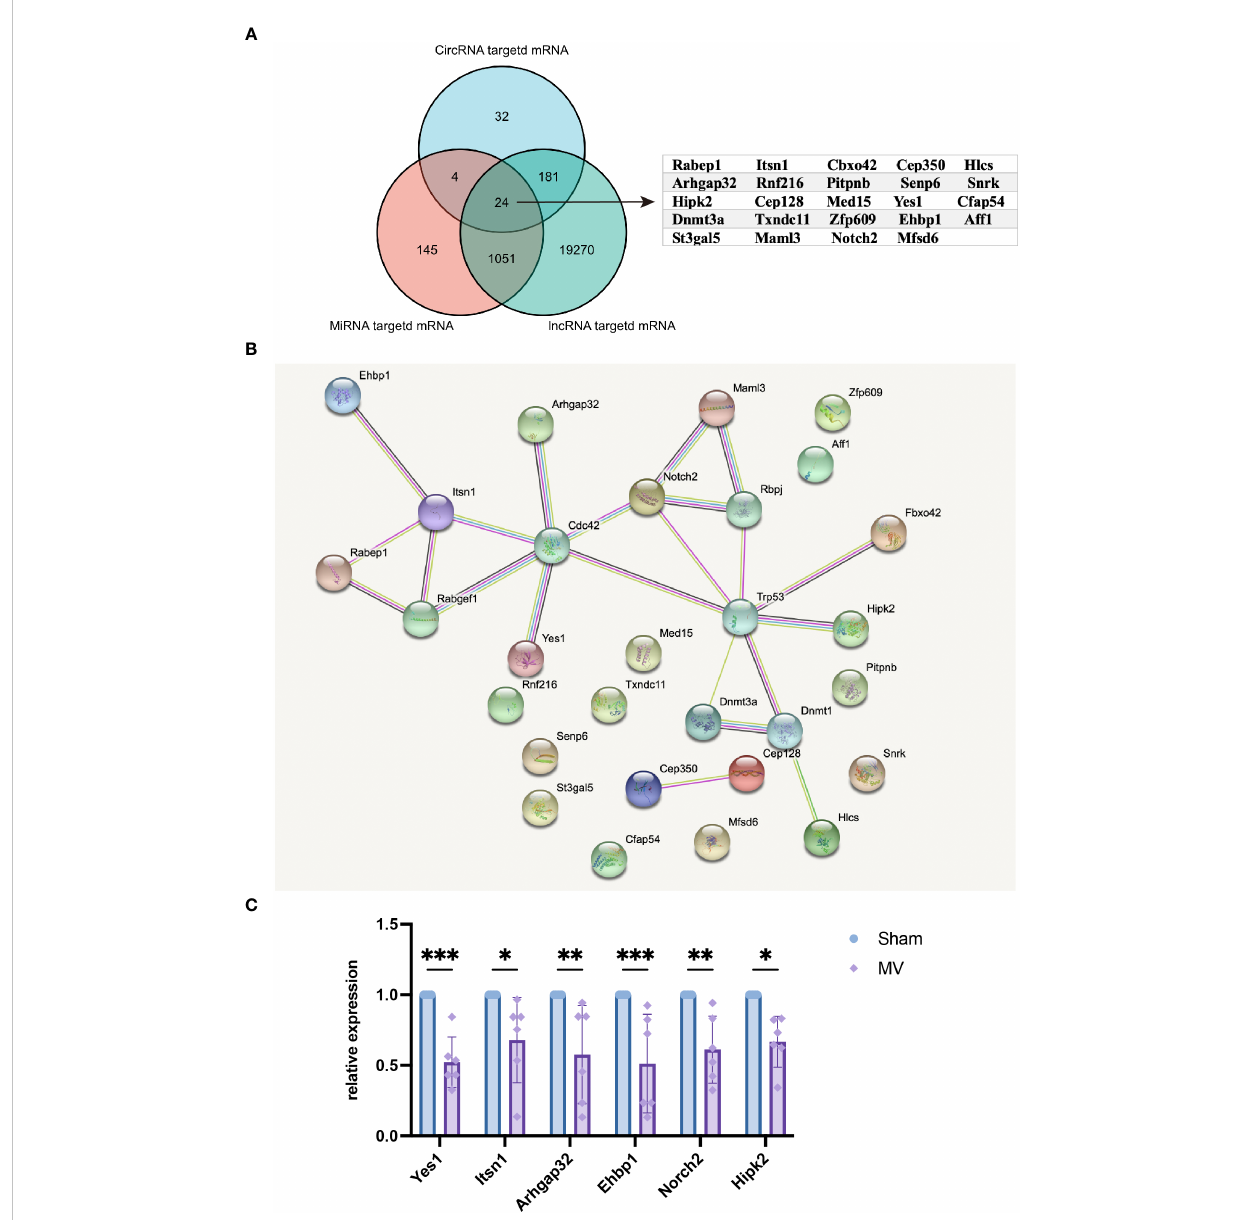
FIGURE 5 Crosstalk between differentially expressed ncRNA-targeted mRNA (A) Venn diagram showed the interaction of ncRNA-targeted mRNA. (B) PPI networks of the key genes. (C) mRNA expression of key genes in pulmonary tissue was determined by qRT-PCR. *p < 0.05, **p < 0.01, ***p <